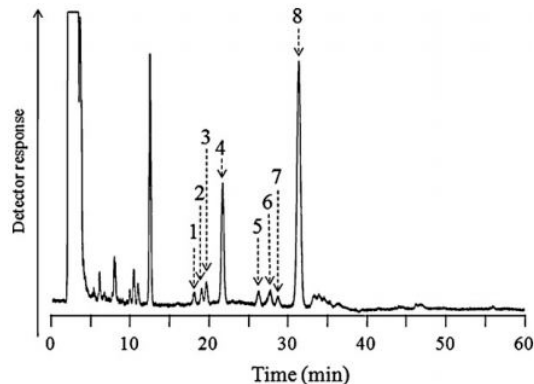
Figure 5. Chromatogram obtained from urine sample with PFOEI derivatization using fluorous LC separation. LC conditions: Column Fluofix-II 120E column (250 mm x 4.6 mm i.d.): mobile phase, acetonitrile-water-trifluoroacetic acid (60:40:0.05, v / v ): flow rate, 1.0 mL/min: column temperature, 30 °C. Peaks and concentrations (nmol/mL urine): 1, DOPA (6.4): 2, NE (4.3): 3, 5-HTrp (1.6): 4, E (1.7): 5, DA